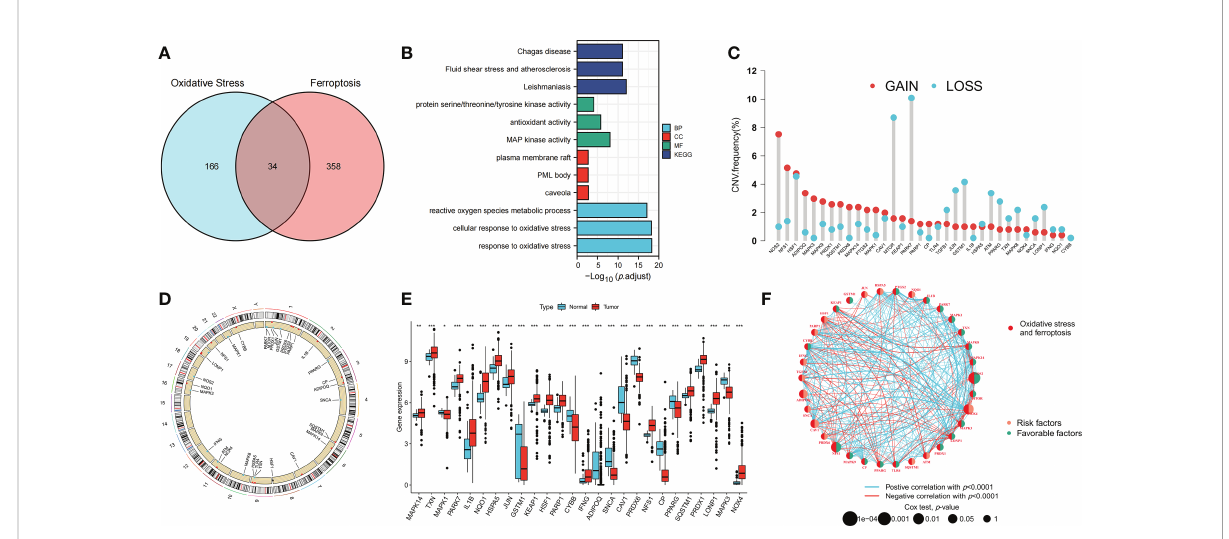
FIGURE 1 Genetic, transcriptional alterations and functional analyses of OFRGs in CRC. (A) Identi fi cation of 34 OFRGs. (B) GO and KEGG analyses of OFRGs. (E) Expression levels of differentially expressed OFRGs between normal and tumor samples. (C) Frequencies of CNV gain, loss, and non-CNV among OFRGs. (D) Locations of CNV alterations in OFRGs on 23 chromosomes. (F) Interactions among OFRGs in CRC. The lines among the genes represent their interactions. Blue and red represent positive and negative correlations. * p < 0.05; ** p < 0.01; *** p <